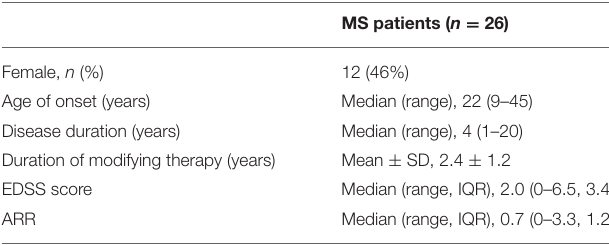
TABLE 1 | Clinical characteristics of the